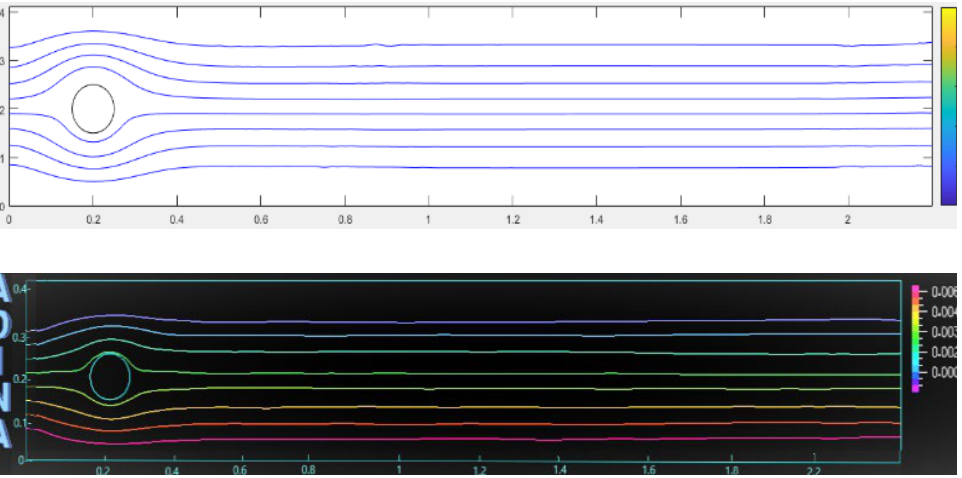
Figure 8. Solution computed with MATLAB ( above ) and with the ADINA system ( below ). The plots show the streamlines associated with a α 1 = 10 − 4 , α 2 = 1. Isobar lines: Figures 9 and 10 present the isobar lines in the following different cases and , . −6 −4 𝛼𝛼 2 = 10 𝛼𝛼 1 = 10 𝛼𝛼 2 = 1